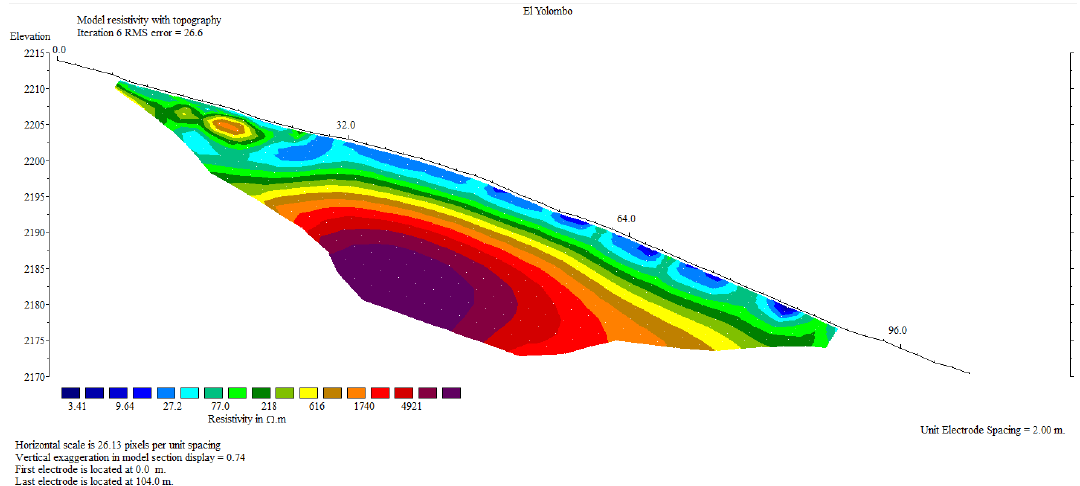
Figure 8. Resistivity model illustrated in Figure 7, but with the topography correction. Cross-section location is depicted by a green line in Figure 1 (T1).